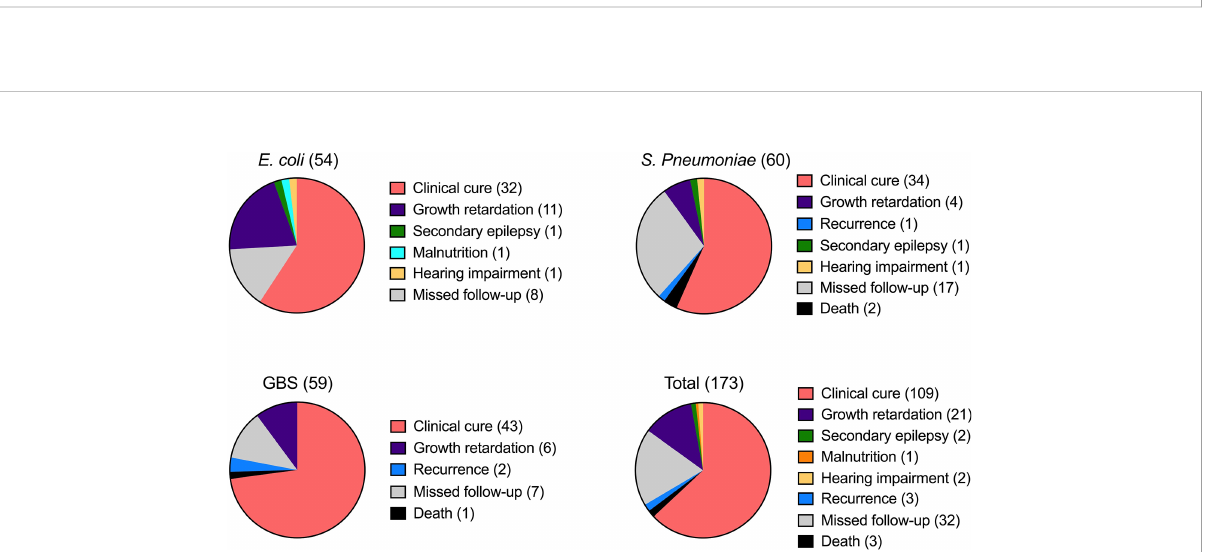
FIGURE 2 Clinical outcomes of BM. The outcome of BM infection was recorded and percentage of the indicated sign were shown for each infection. The number of cases was shown in